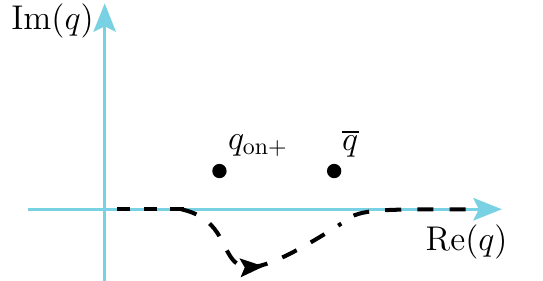
Fig. 3 Pole positions for the case of cos θ = − 1 when q can be pos- itive. The line shows the contour path that one can take to avoid the